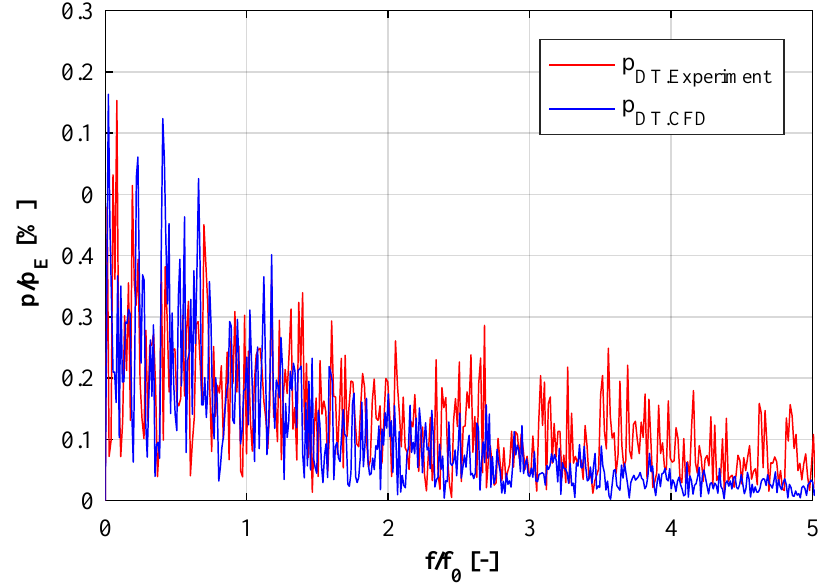
Figure 7. Compartment of simulation and experiment by means of pressure